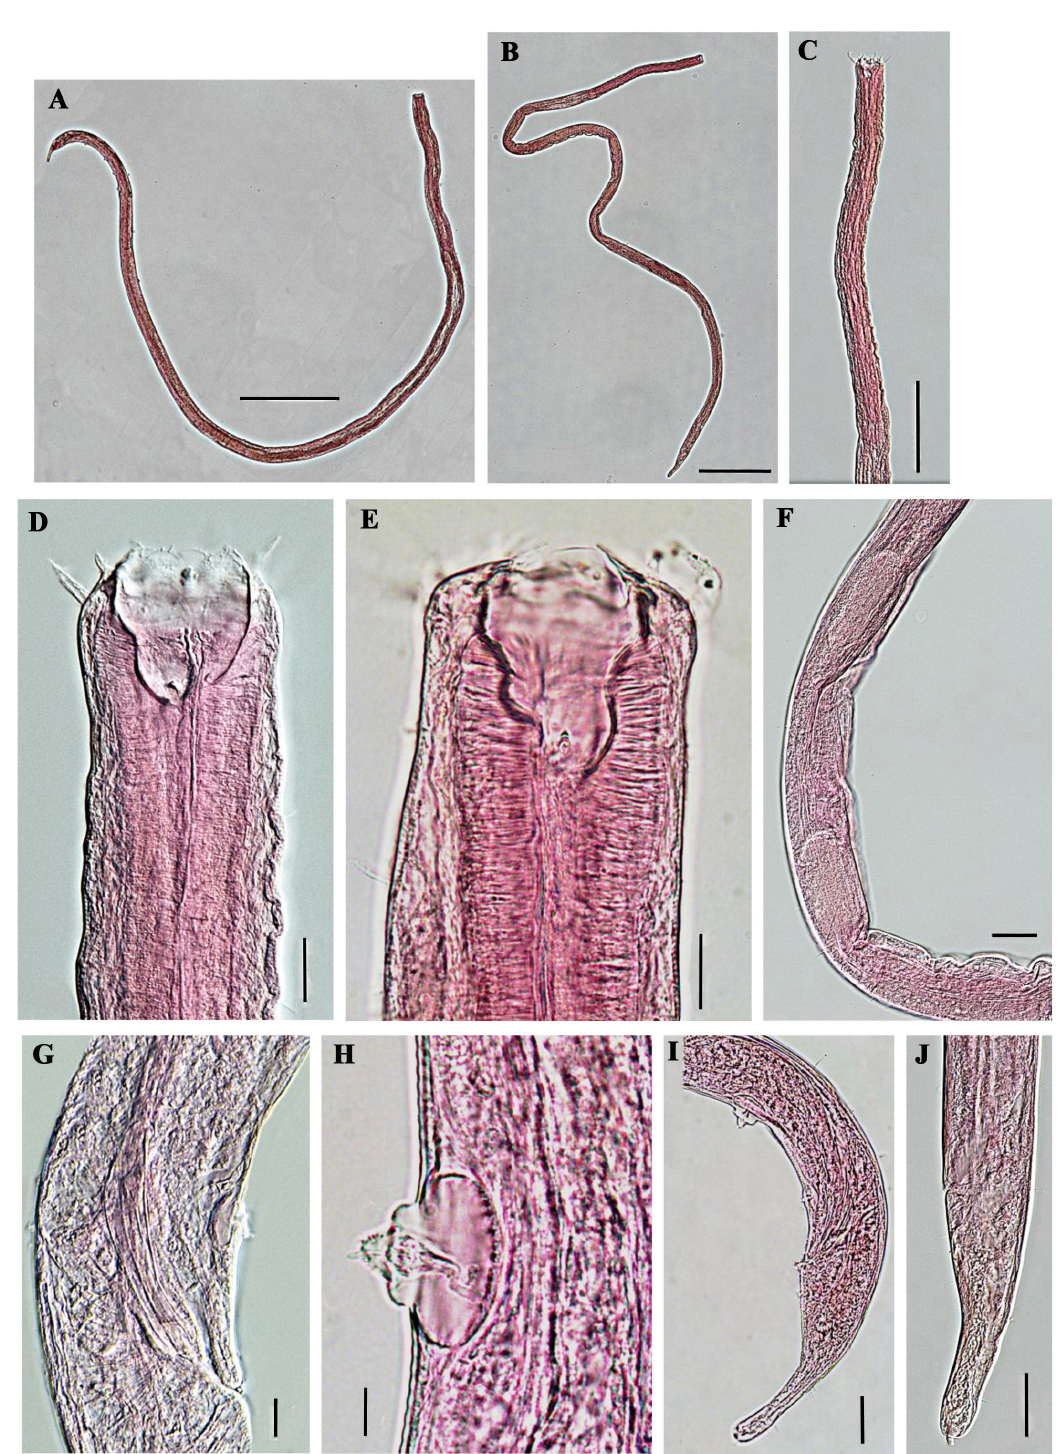
Fig. 2. Paratrilobus tankhoyensis sp. nov., light micrographs. A . Entire male. B . Entire female. C . Male pharyngeal region. D . Male anterior end. E . Female anterior end. F . Female vulva region. G . Male cloacal region. H . Male precloacal supplement. I . Male posterior body end. J . Female posterior body end. A, H–I: holotype (HM RAS 102/71 1538-2); B, E, J: paratype (HM RAS 102/71 1538-3); C–D, G: paratype (HM RAS 102/71 1538-4), F: paratype (HM RAS 102/71 1538-1). Scale bars: A–B = 500 µm; C–E = 20 µm; F, I–J = 50 µm; G–H = 10